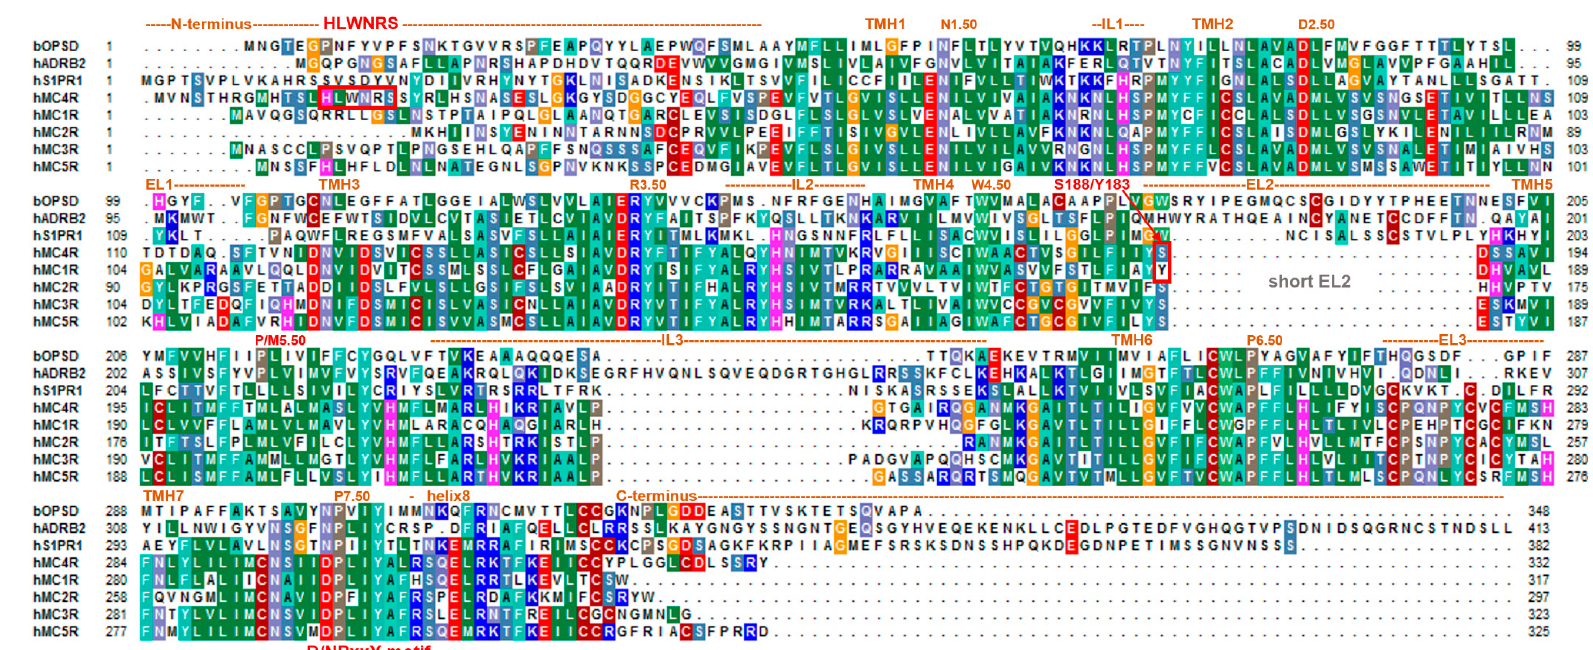
Figure 2. Sequence alignment of the MC4R and homologous MCRs in comparison to bovine rhodopsin (bOPSD), the β 2 -adrenergic receptor (ADRB2), and the sphingosine 1-phosphate receptor 1 (S1PR1). This comparison visualizes predicted structural dimensions of each MC4R part, also assigned according to the recently solved MC4R inactive-state structure (PDB ID: 6W25) [21], such as the helices or loops (IL, intracellular loops; ELs, extracellular loops; TMH, transmembrane helices). Highly conserved positions, according to the unifying Ballesteros and Weinstein numbering scheme for class A GPCRs [83], are indicated by respective numbers. This alignment was visualized using the BioEdit software [84]. Specific background colors indicating conservation (Blossum62 matrix) and reflecting biophysical properties of the amino acid side chains as follows: black—proline, blue—positively charged, cyan/green—aromatic and hydrophobic, green—hydrophobic, red—negatively charged, gray—hydrophilic, dark-red—cysteine, and magenta—histidine.